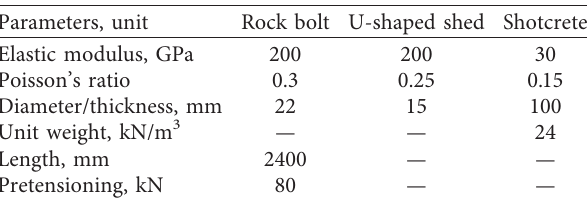
Figure 3: The established 2D numerical models for roadway. (a) The geometry and coal measures stratum of the model. (b) Enlarged view of traditional support. (c) Enlarged view of JG support Table 3: Properties of support materials.